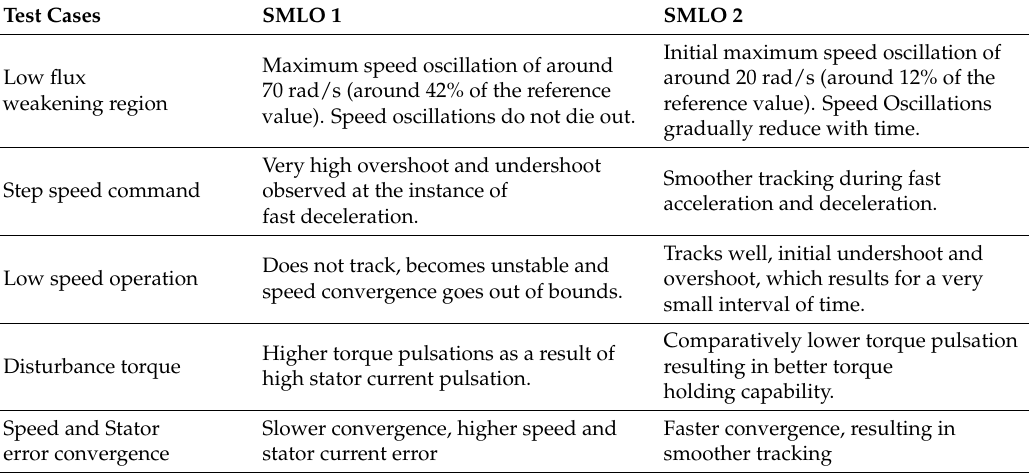
Table 1. Salient features of both the observers.